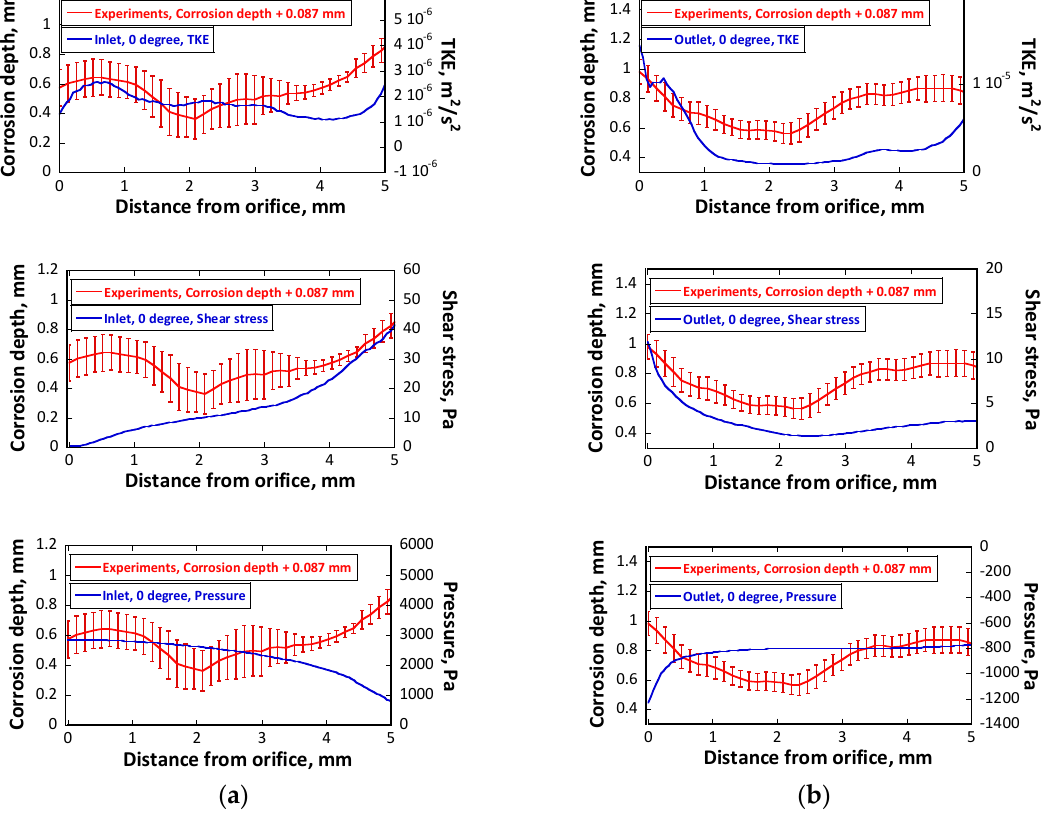
Figure 9. Comparison of the average corrosion depth with the turbulent kinetic energy (TKE) near the wall and the shear stress and pressure on the wall for the two orifices. ( a ) Inlet orifice; ( b ) Outlet